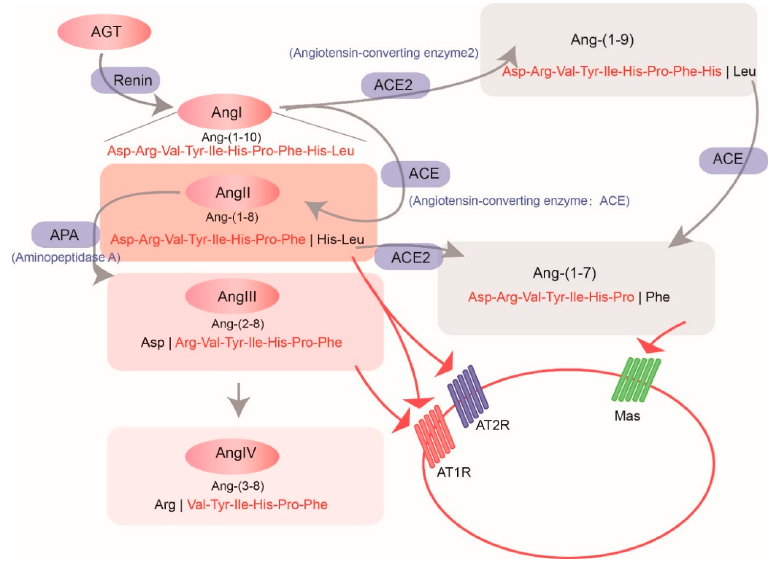
Figure 1. The classical pathway of vertebrate renin–angiotensin system (RAS). Grey arrows emphasize the enzymes that catalyze related reactions. Red words stand for the products, and the “|” between red and black words indicate the cleavage sites.